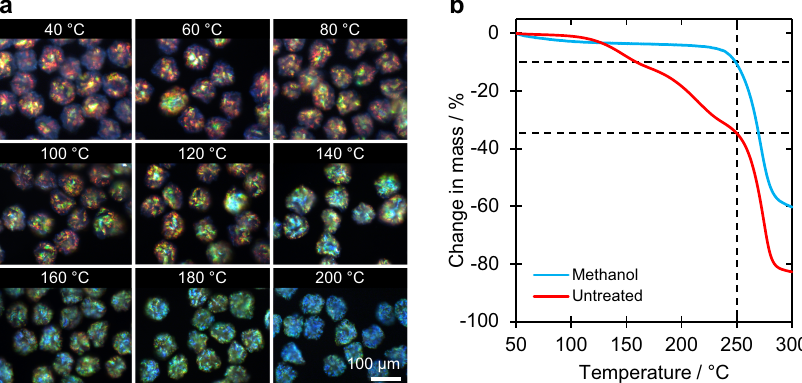
Fig. 3 The impact of residual water on the optical appearance of CNC microparticles. a Dark- fi eld micrographs showing the effect of thermal treatment at different temperatures on the re fl ected colour of n -hexane washed CNC microparticles. b Thermogravimetric analysis (TGA) from 50 to 300 °C for a sample of CNC microparticles with, and without, treatment with methanol. The marked difference in the two curves is attributed to the removal of almost all the residual solvent trapped within the CNC